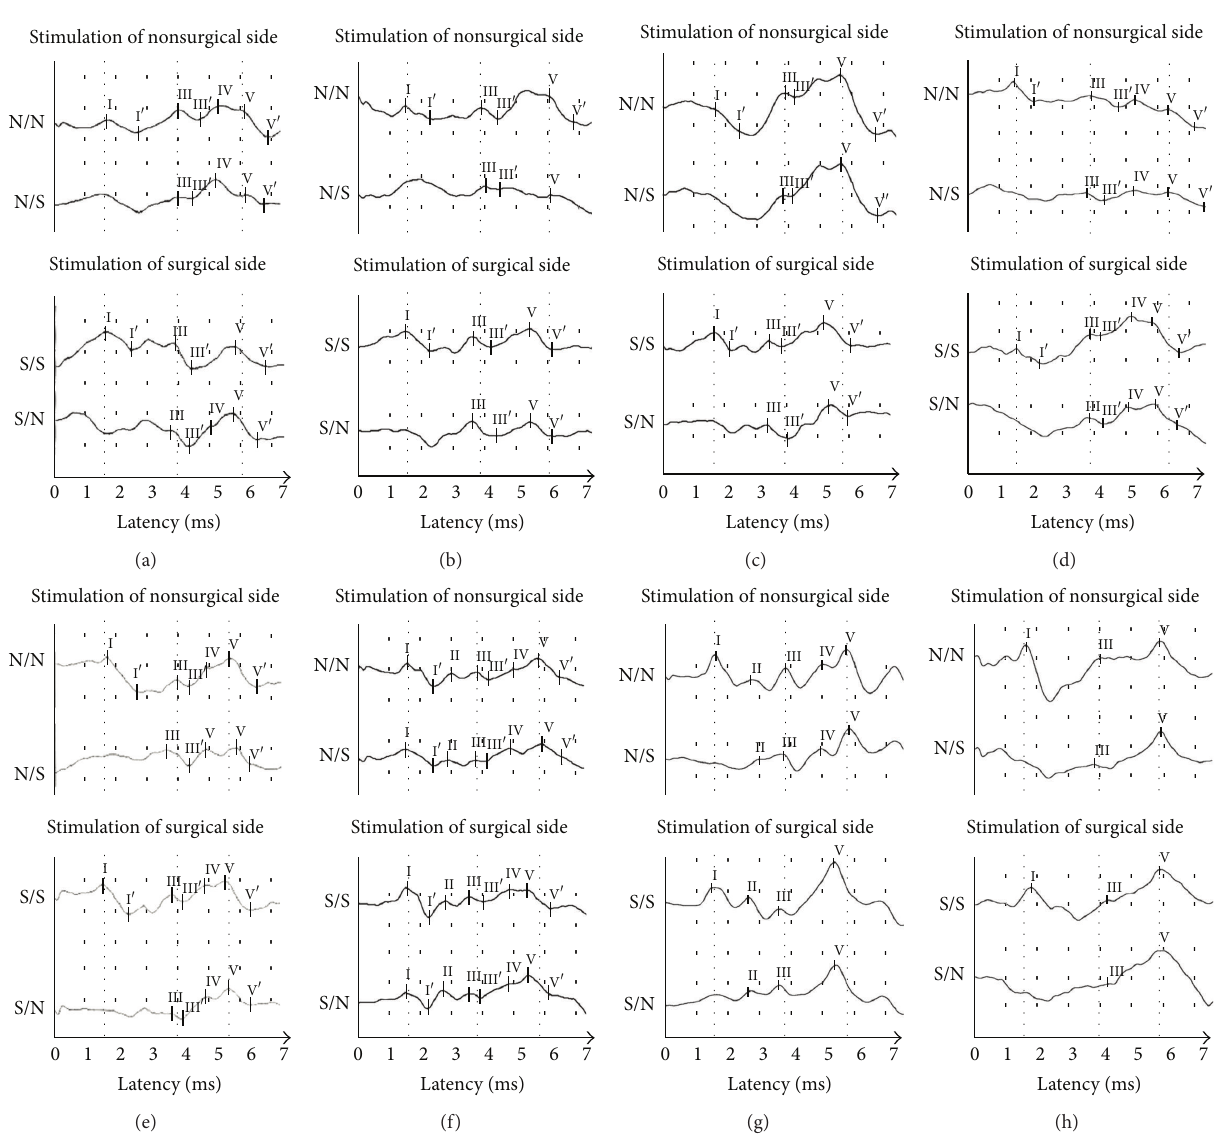
Figure 2: These are the ABR waveforms for all patients. The 3 vertical dotted lines from left to right represent locations of Waves I, III, and V induced by the test